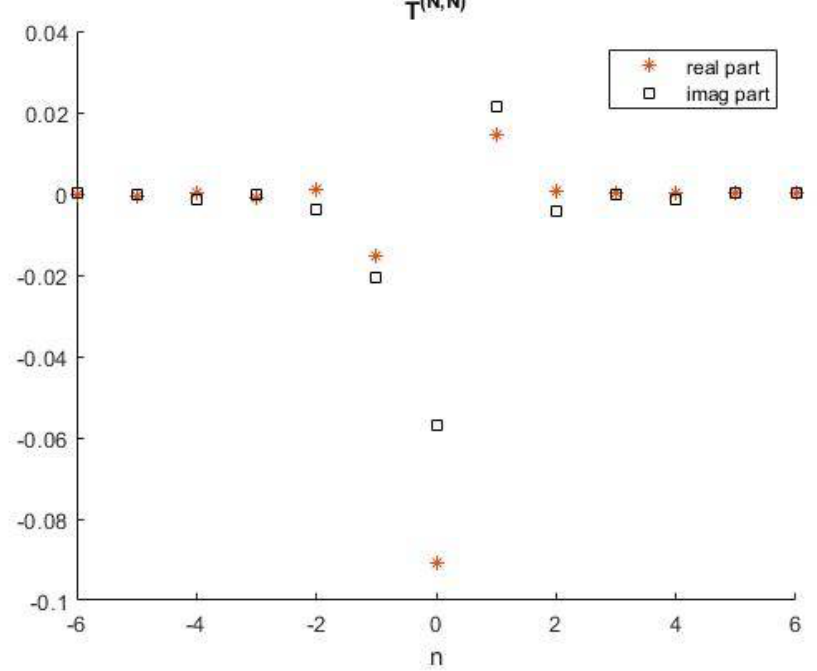
Figure 3. Plot the f vv versus φ s for fixed θ i = 140 ◦ , φ i = 0 ◦ , and θ s = 140 ◦ , and N max = 6, n (cid:48) = 0. (In the FEKO, we simulate 37 points, and in the MATLAB, we interpolate it to 370 points).